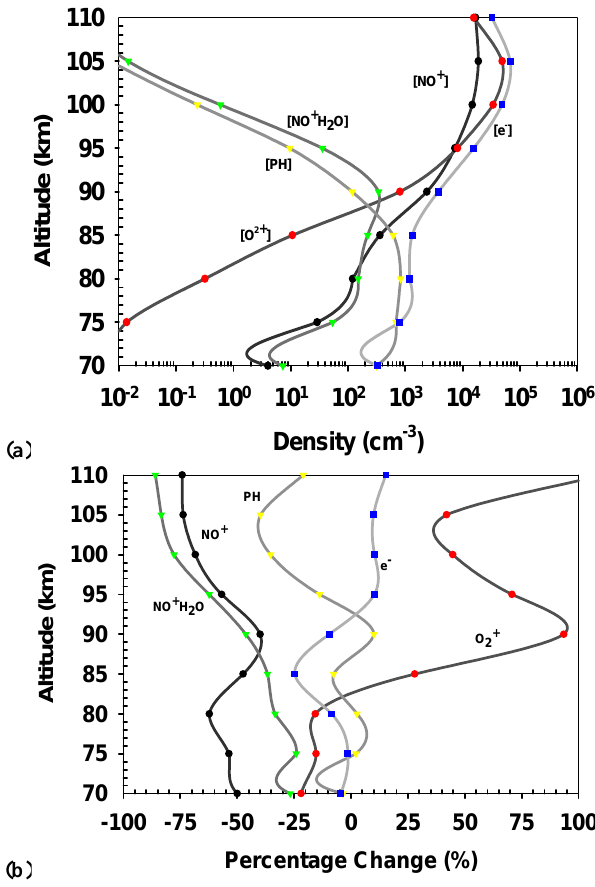
Fig. 2. (a) The number density (/cc) of major positive ions in the MLT region for background case; (b) Model results of percentage change in major positive ions for the double-CO 2 scenario in the MLT region at 10 ◦ N latitude as obtained in this